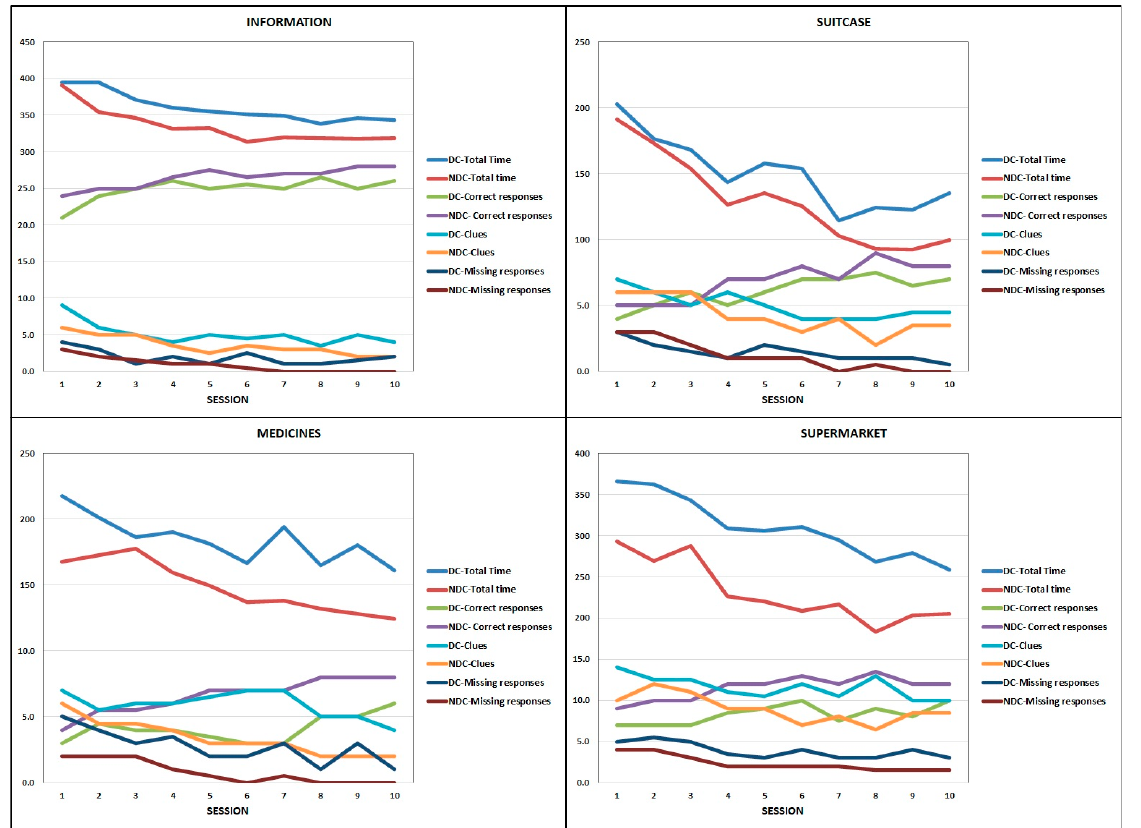
Figure 1. Median number of correct responses, missing responses, and clues, and median values of the total execution time (expressed in s), observed in both degenerative and non-degenerative conditions (DC and NDC) of the EG across the 10 VRT sessions, for each task.